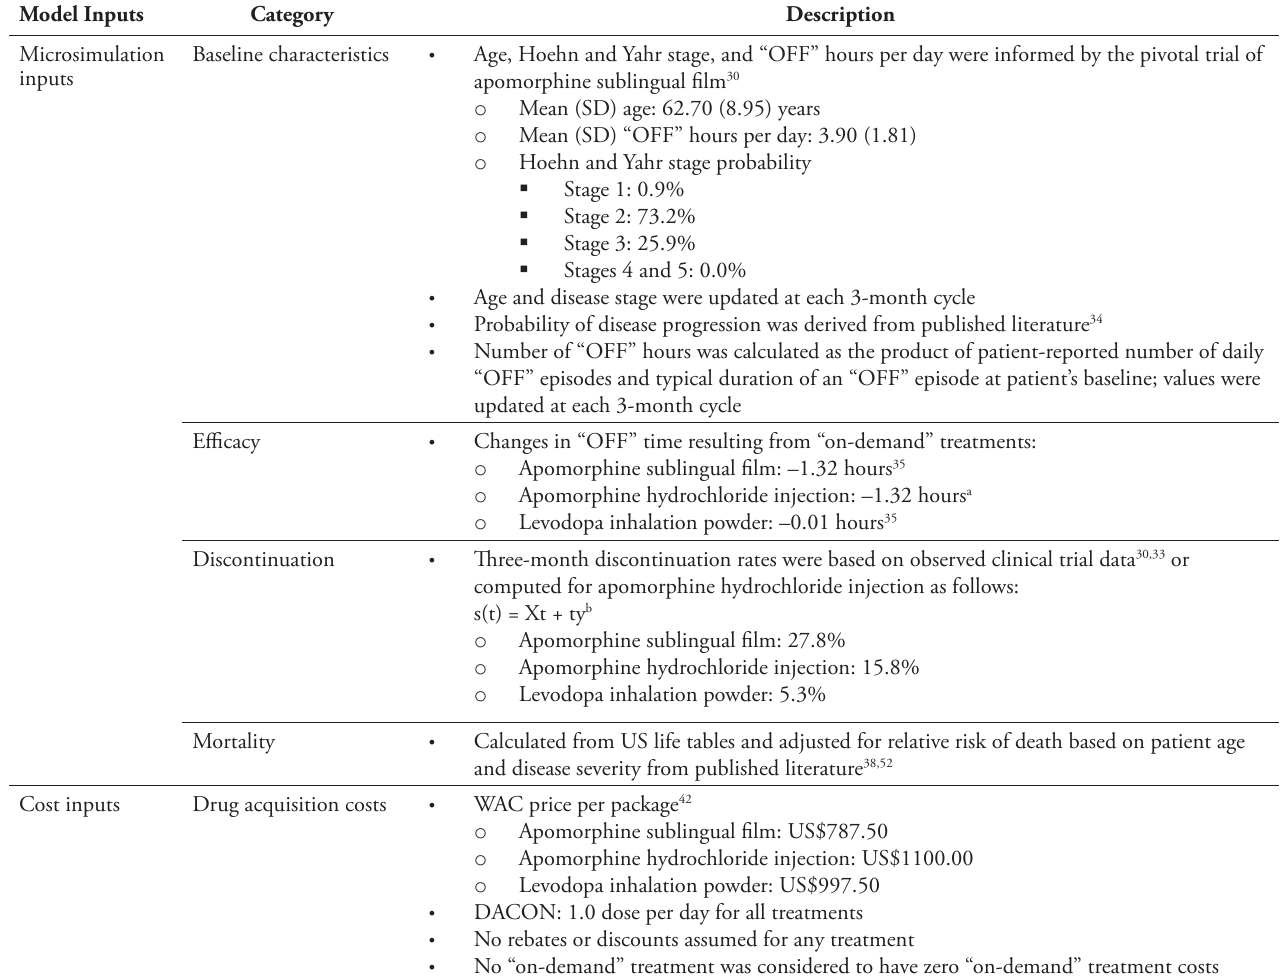
Baseline Characteristics Inputs